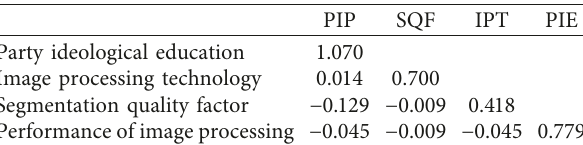
Table 3: Covariance. Table 4: Standardized regression